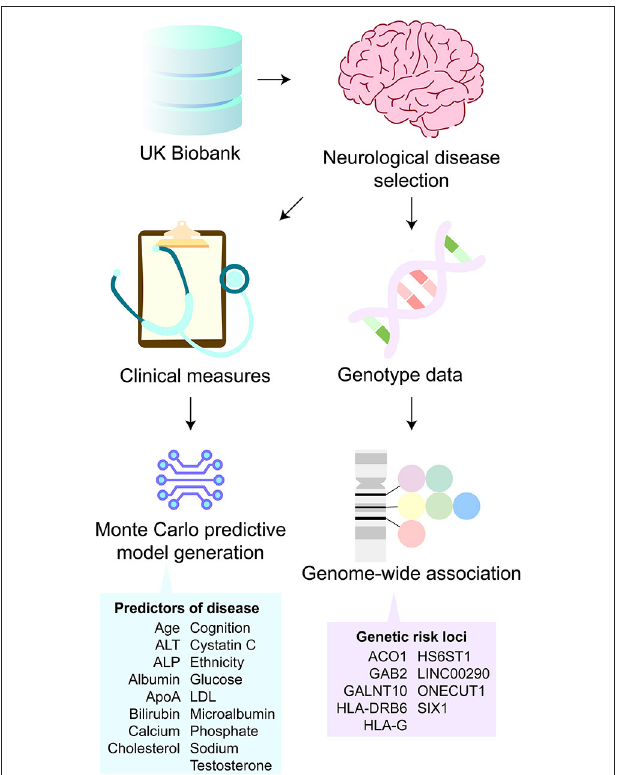
FIGURE 1 | Study overview. From UK Biobank participants, Alzheimer’s disease, Parkinson’s disease, motor neuron disease (MND), and myasthenia gravis clinical and genotype data were obtained. The clinical data were used to train a predictive model of neurological diseases. The model was deconstructed to reveal predictors of disease relating to demographics, cognitive scores, and liver health biomarkers. The genotype data were used to perform genome-wide association studies. This analysis revealed nine genetic risk loci that were shared among all four neurological diseases.